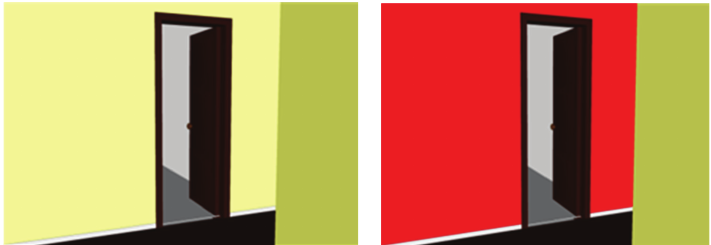
Figure 8: Chromatic alteration of the coating according to its state of